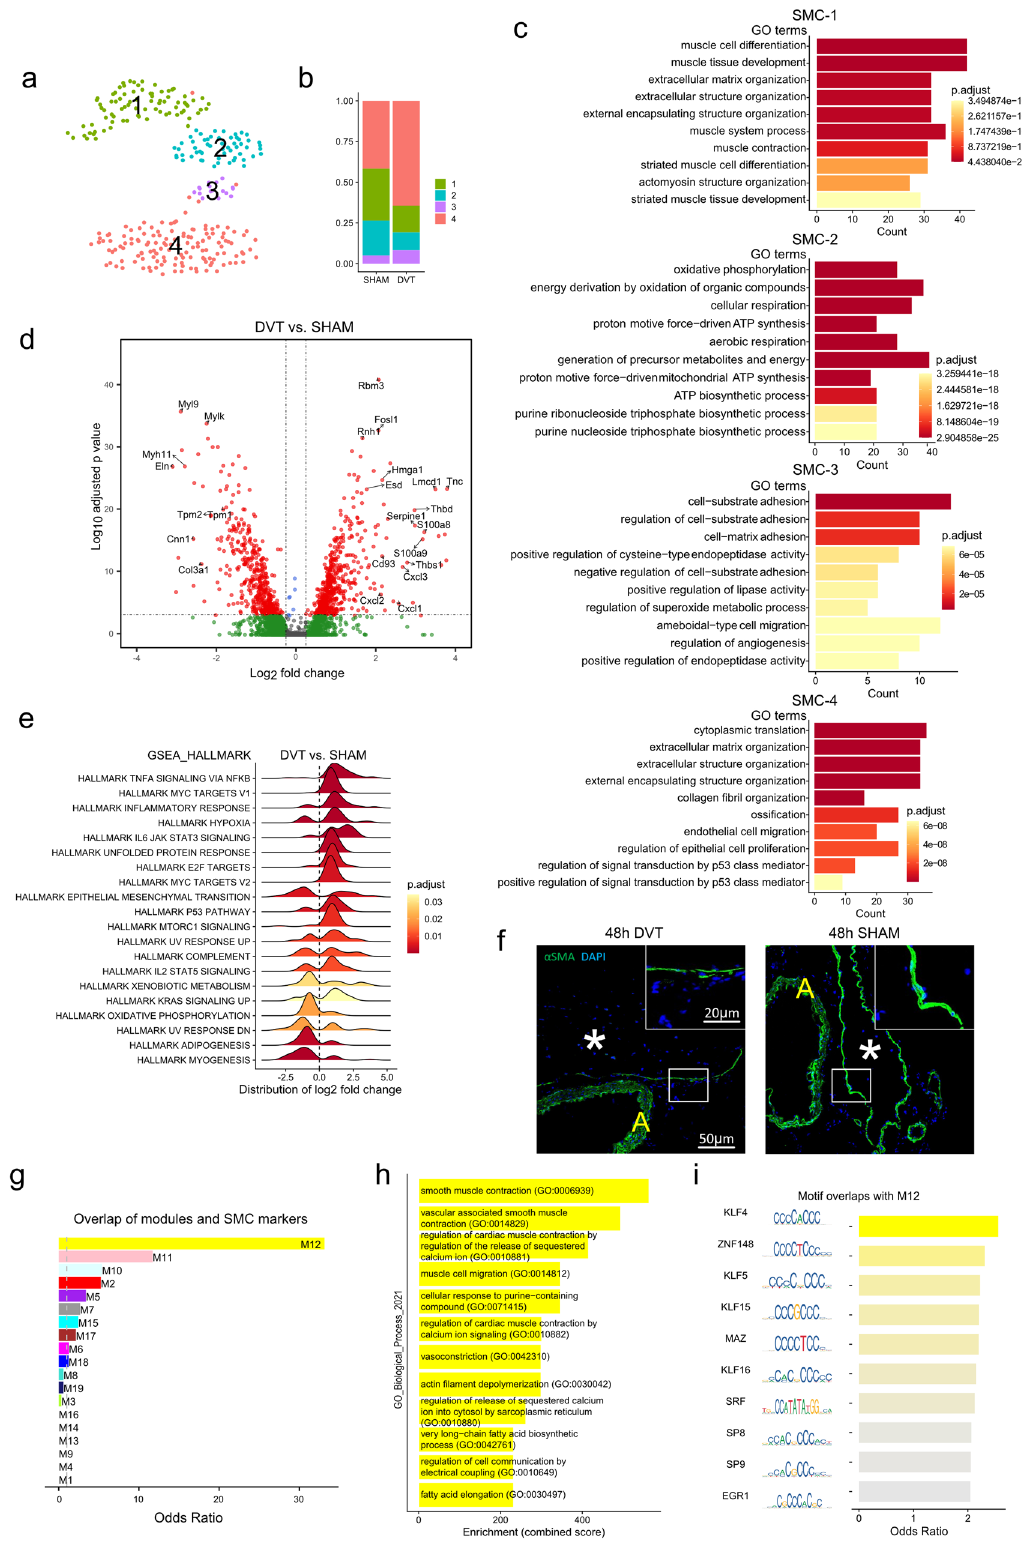
Fig. 2 Gene expression heterogeneity of smooth muscle cells (SMCs). a UMAP plot of sub-populations in SMCs of sham and DVT data combined. b Relative distribution of sub-populations in sham and DVT groups. c Gene Ontology (GO) analysis of each SMC sub-population in comparison to the other three sub-populations. d Volcano plot of DEGs in total SMCs (DVT vs sham group). e GSEA of the altered gene sets in DVT versus sham group. f Immunostaining of smooth muscle cell marker α -smooth muscle actin ( α -SMA) within IVC or IVC/thrombus cross-sections 48 h after sham surgery or IVC ligation (DVT group). DAPI was used to stain nuclei. Vessel lumen or thrombus depicted with asterisk. Yellow “ A ” indicates aorta. Area encompassed by white dotted box is shown magni fi ed in the insert. N = 3 mice for each group. g Association between SMC markers and each co-expression module. h Enriched biological processes in module 12. i Association between transcription factor binding motifs and module